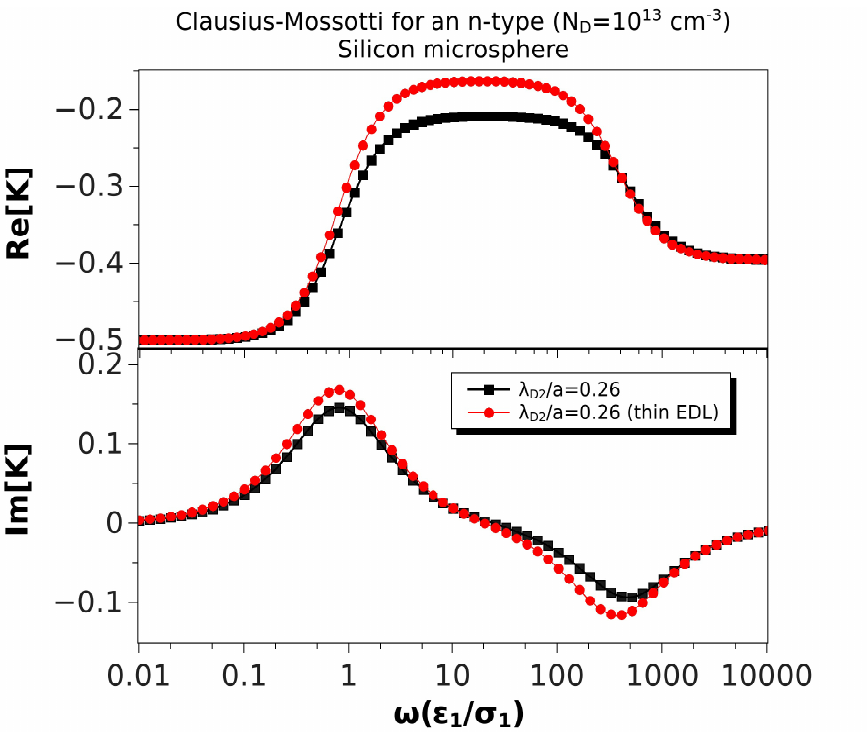
Figure 5. Real and imaginary parts of the Clausius–Mossotti factor versus nondimensional frequency for an n-type silicon ( N D = 10 13 cm − 3 ) microsphere (10 µ m) immersed in a KCl solution. The nondimensional Debye length in the particle is ¯ λ D 2 = 0.26. The results of the thin EDL approximation (Equation (35)) are compared with the exact solution, Equation